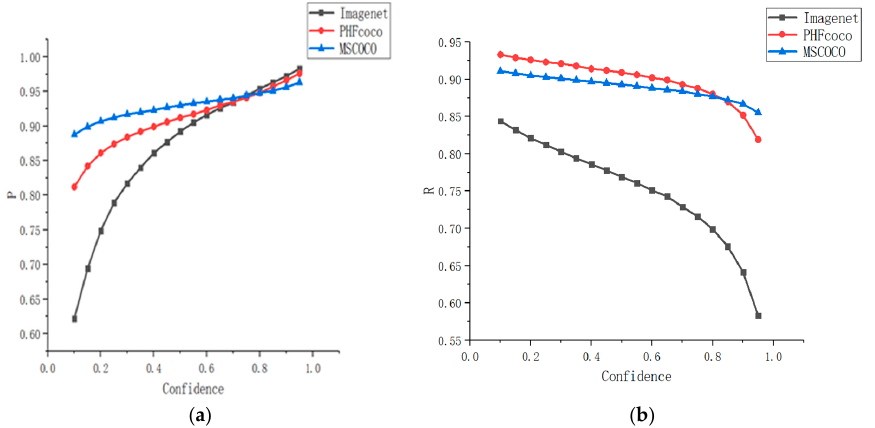
Figure 4. ( a ) Detection accuracy obtained on different datasets at IoU threshold of 0.5; ( b ) recall obtained on different datasets at the IoU threshold of 0.5.